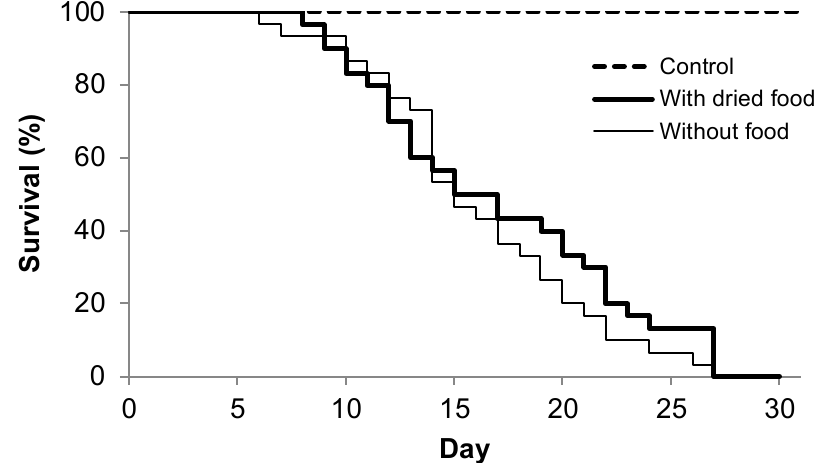
Figure 2. The survival analysis (log-rank test; p < 0.3922) of L3 pine-tree lappet Dendrolimus pini larvae for three variants of breeding, i.e., with food (control), with a mix of dried food (with dried food; see Materials and Methods), and without food. The log-rank test was carried out only for the “with dried food” and “without food” treatments.